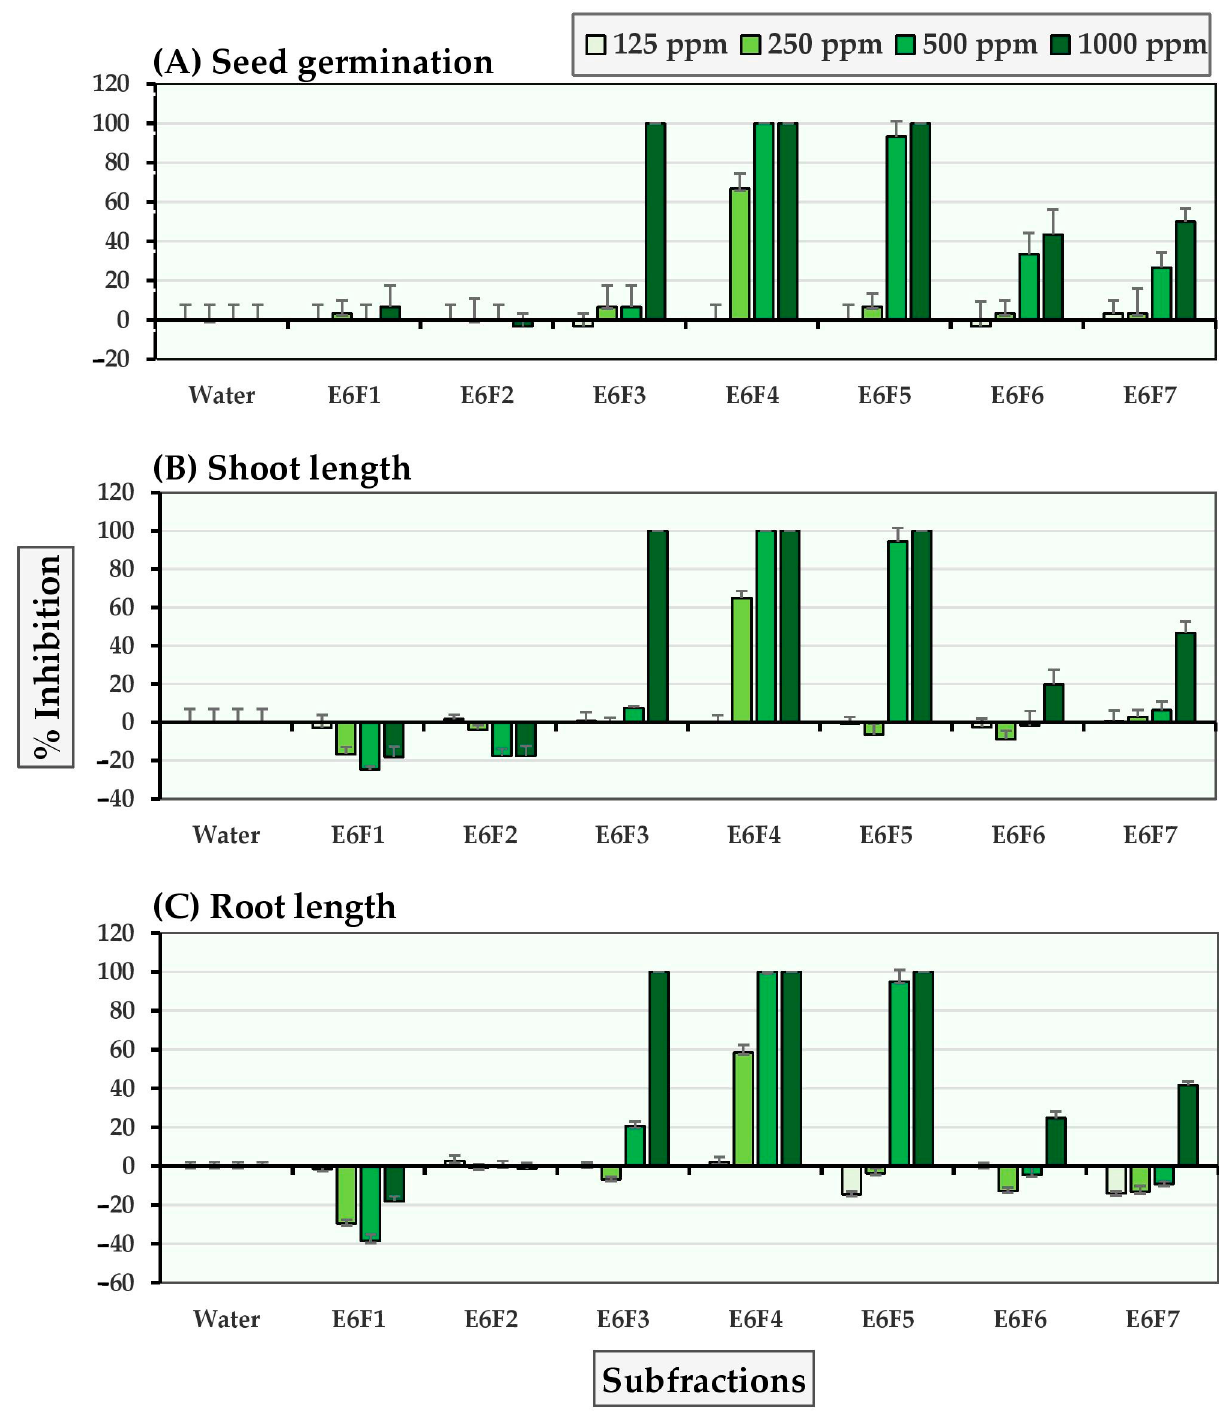
Figure 1. Inhibitory effects of S. platensis E6 subfractions on ( A ) seed germination, ( B ) shoot length, and ( C ) root length of Chinese amaranth . Distilled water was used as a control.